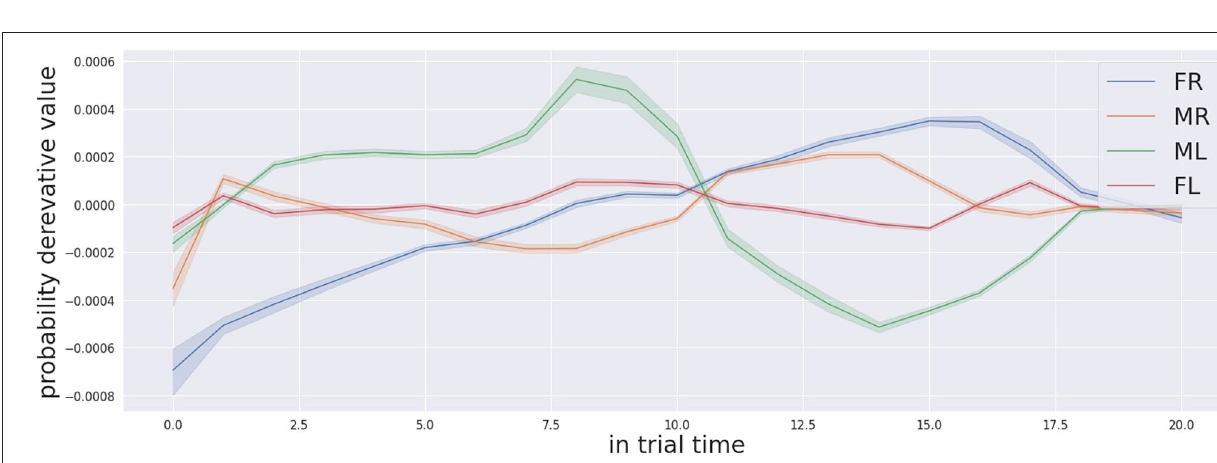
FIGURE 12 | The derivative of the audio probabilities profile for the trials that the middle left box (ML in green colour) was